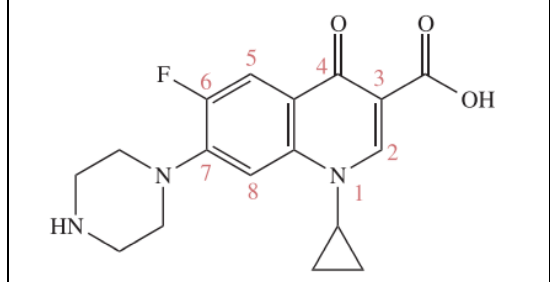
Figure 4. Ciprofloxacin (CIP) chemical structure.